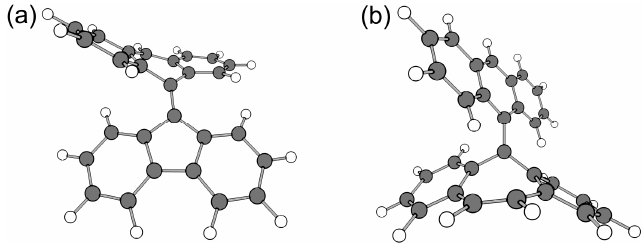
Figure 13. Structures of the transition state of ( a ) 11 and ( b ) 13 calculated at the UBLYP-D3/6-31G** level of theory.